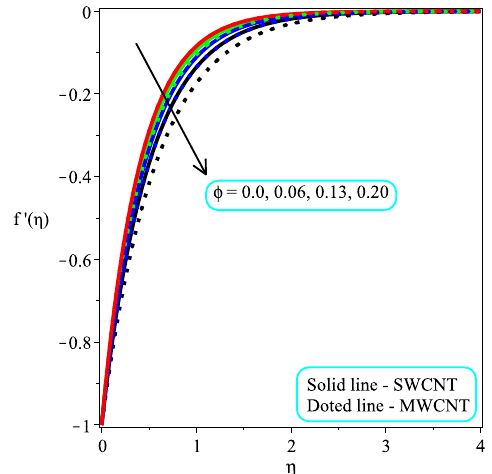
Figure 2. Repercussion of φ with M egt = 1, Ω = 3, κ = 2, ω = π /3 on velocity on velocity